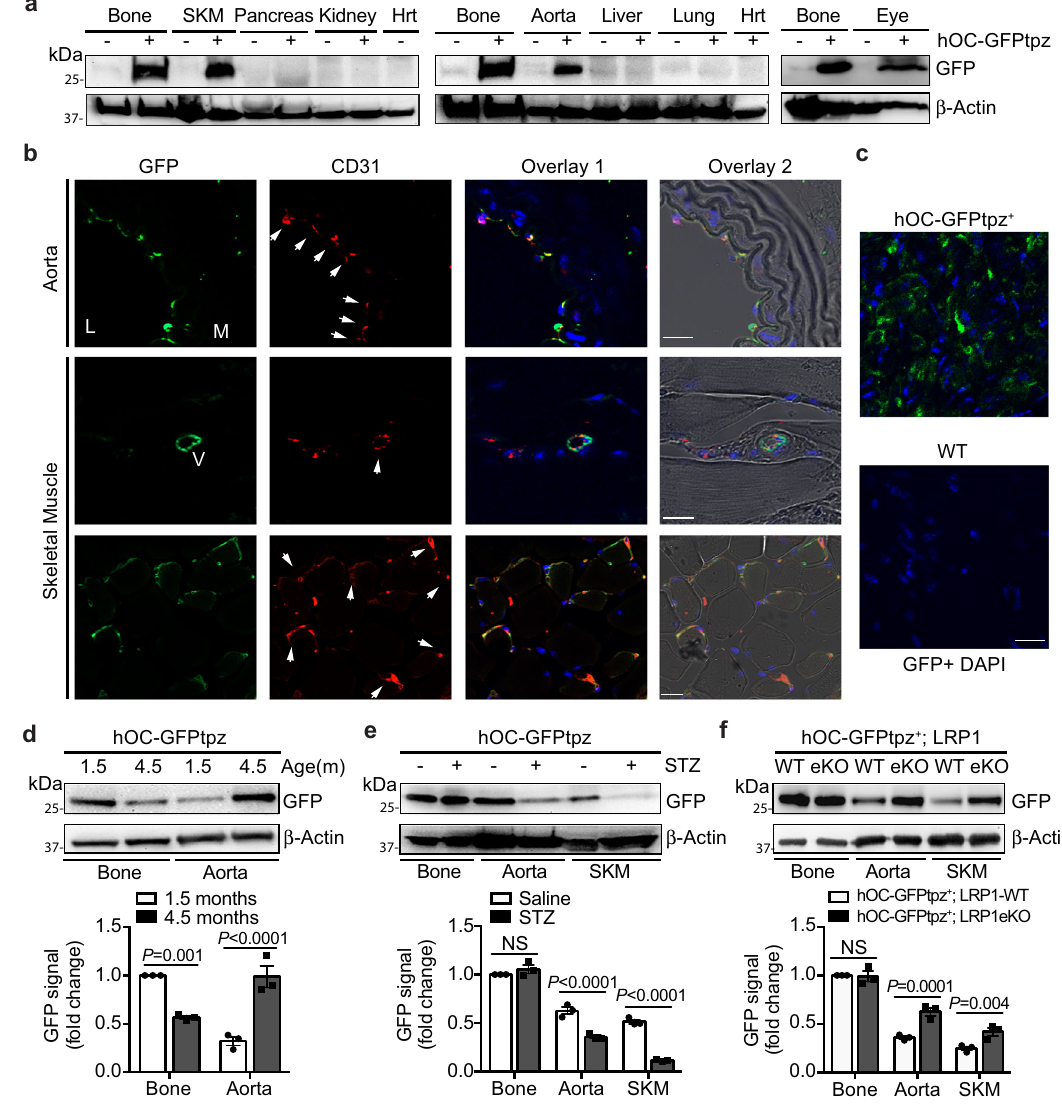
Fig. 2 The ocn promoter-driven GFP expression in ECs. a – c The ocn promoter-driven GFP expression was detected in aorta and other tissues of hOC- GFPtpz mice, determine by Western blotting ( a ), cross-section staining with aorta and skeletal muscle ( b ) and en face staining with aorta ( c ). SKM, skeletal muscle. Hrt, heart. Arrows indicate GFP-positive ECs. L, lumen. M, media. V, vessel. Negative control images with tissues of non-transgenic mice are shown in Supplementary Figure 2j. d GFP levels in bone and aorta isolated from hOC-GFPtpz mice at indicated age. e GFP levels in bone, aorta and skeletal muscle isolated from streptozotocin (STZ)-induced diabetic or control hOC-GFPtpz mice. f GFP levels in bone, aorta and skeletal muscle isolated from LRP1 eKO; hOC-GFPtpz or WT; hOC-GFPtpz mice. Scale bar, 20 μ m. n = 3 ( d – f ). NS, not signi fi cant. Data are presented as mean ± SEM. Analysis was two-way ANOVA followed by Fisher ’ s LSD multiple comparison test ( d – f